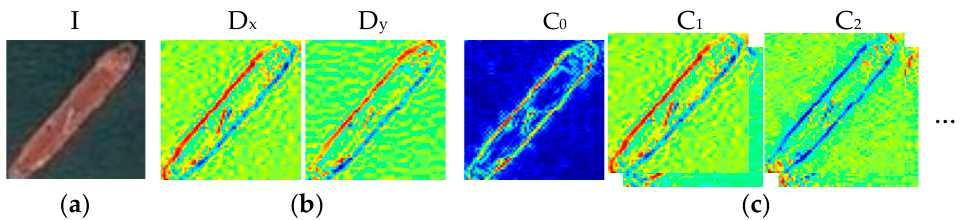
Figure 7. The expansion process from the gradient images to the Fourier coefficient images. ( a ) Input image. ( b ) Gradient images. ( c ) The Fourier coefficient images. Note that the real and imaginary parts of the Fourier series are shown separately.